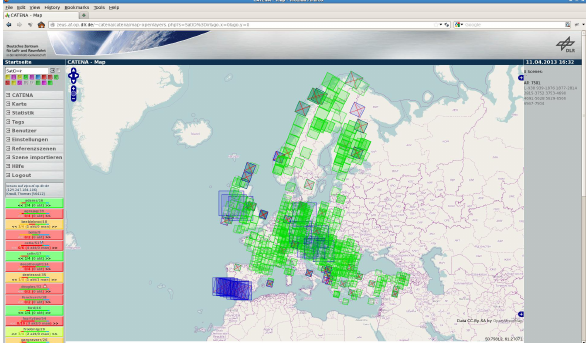
Figure 10: CATENA web-interface showing a map of actual IRS- P6 AWiFS and Liss3 scenes, green: finished, blue: unfinished, green X: working, red X: error